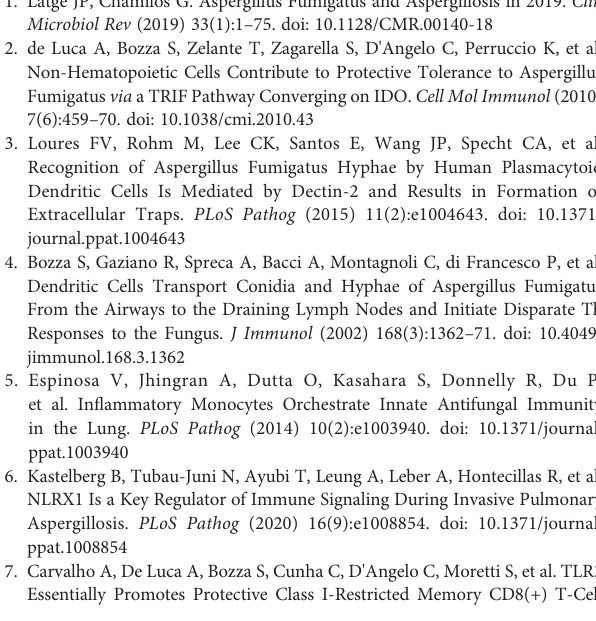
Supplementary Figure 3 | Reactive oxygen species and oxidative stress production by wild type and Nlrx1 de fi cient bone marrow derived neutrophils in response to fungal PAMPs and A. fumigatus . Wild type and Nlrx1 de fi cient bone marrow derived neutrophils (BMDNs) were pre-incubated with (A – G) a fl uorescent dye speci fi c for superoxide production or (H – N) a fl uorescent oxidative stress (OS) indicator. Production of (A, B) superoxide and (H, I) reactive oxygen species by wildtype BMDNs to stimuli (killed conidia, zymosan depleted, zymosan, curdlan, and control PBS) over 6 hours. Cells were then treated with (C, J) curdlan, (D, K) zymosan depleted, (E, L) zymosan, (F,M) killedconidia or (G, N) controlPBSbuffer for 6hrs. Fluorescence was measured at 30, 60, 90, 180, 360 min post treatment. N=8. Error bars denote standard deviation. All experiments were independently repeated. P < 0.05, indicated by asterisk via Kruskal-Wallis test followed by a Dunn ’ s test for multiple